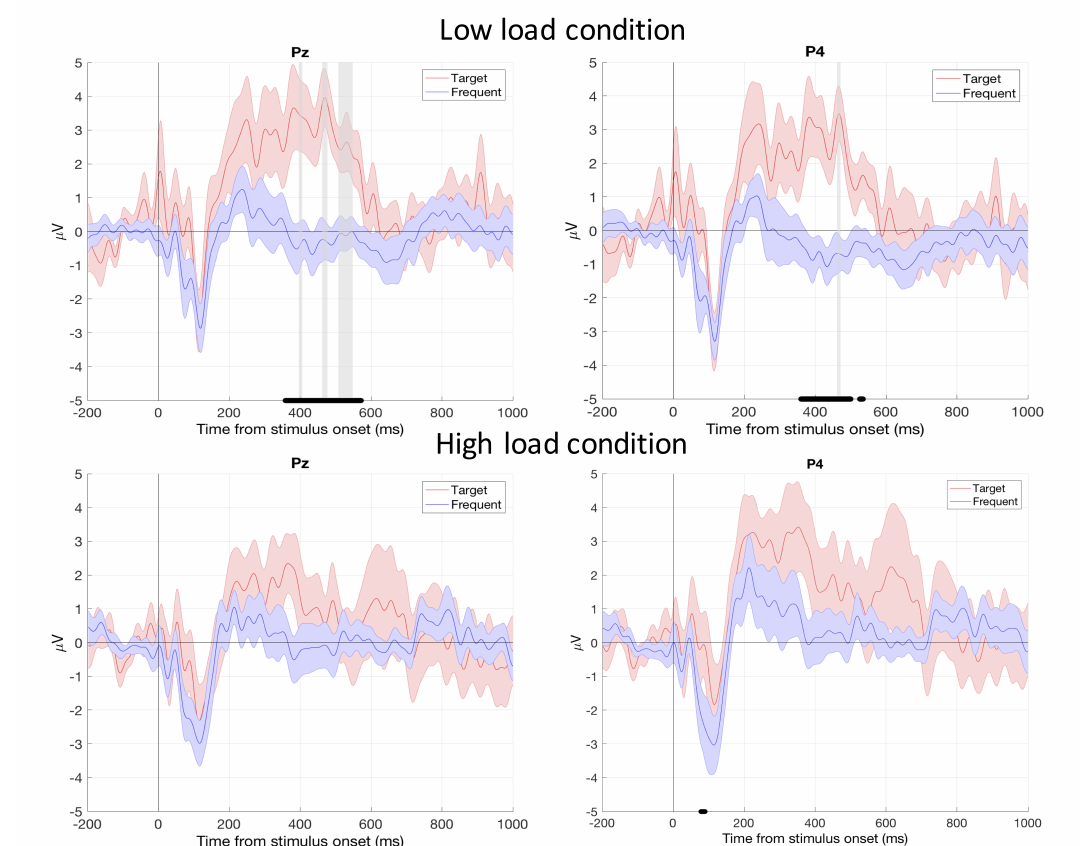
Figure 4. Grand averaged waveforms of the ERPs for parietal electrodes with standard error (shapes). The black lines on the x axis specify the time range when the target sound-related and the frequent sound-related ERP amplitudes were significantly different ( p < 0.01). Up: low load condition. Down: high load condition. The vertical grey bars indicate when the P300 amplitude on the auditory target was statistically higher in the low load compared to the high load condition ( p < 0.001). P300 considered time window was [350 600]